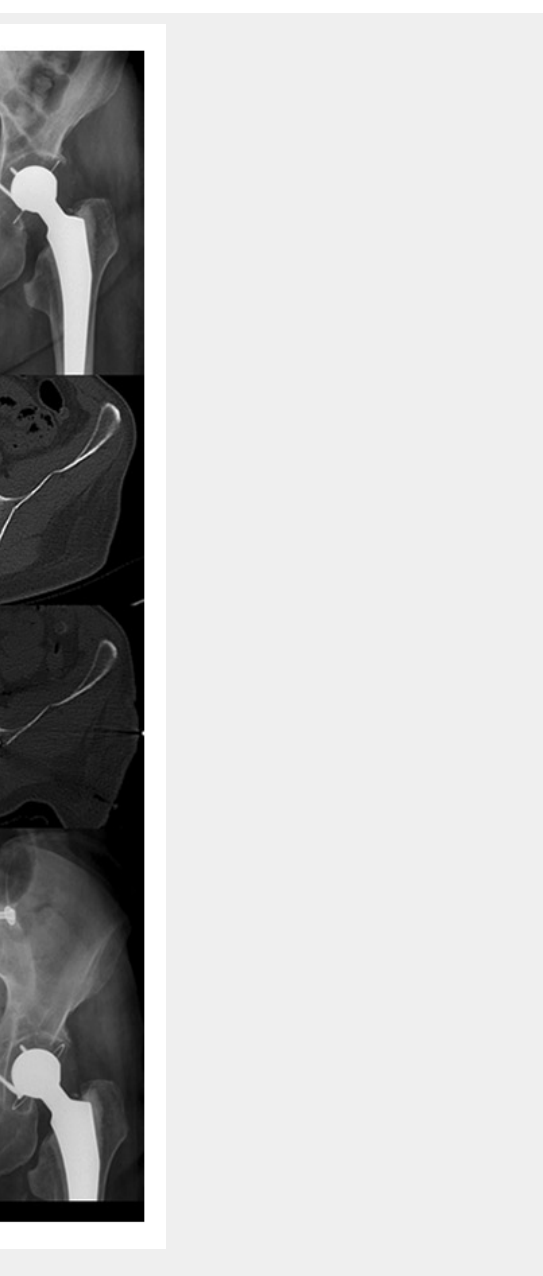
Figure 3 a) pubic ramus fracture on the left side b) CT scan six weeks after initial trauma due to increasing pain: There is a fracture of the massa lateralis on the left and a discontinuation of the cortical bone of the massa lateralis on the right c) CT-guided percutaneous screw fixation d) pelvic X-ray six weeks after